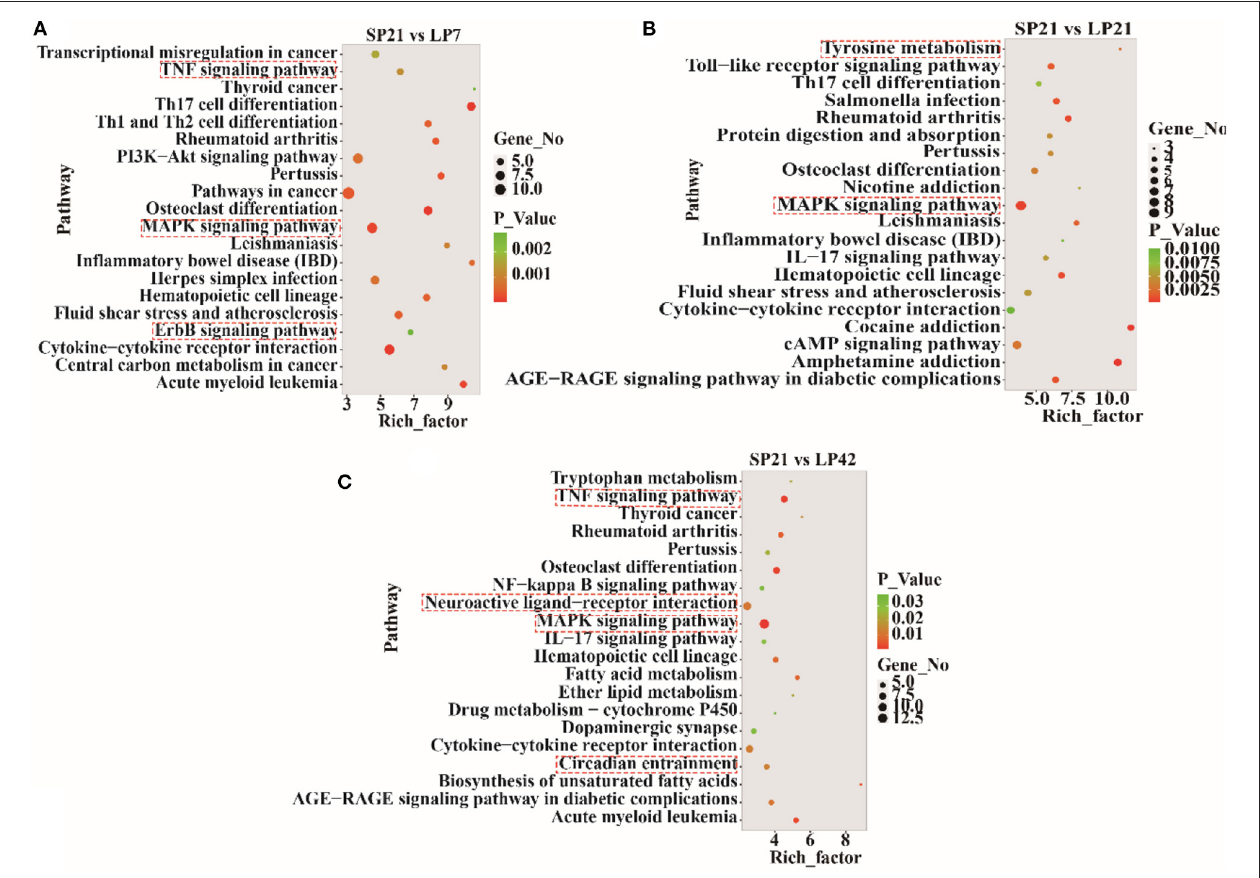
FIGURE 6 | KEGG pathway analysis of differentially expressed mRNAs between short photoperiod and long photoperiod in PT of Sunite sheep. (A) Top 20 enrichment pathways in SP21 vs. LP7. (B) Top 20 enrichment pathways in SP21 vs. LP21. (C) Top 20 enrichment pathways in SP21 vs. LP42. Rich_factor is defined as the amount of differentially expressed genes enriched in the pathway/amount of all genes in the background gene set. The red boxes represent the seasonal reproduction-related terms.